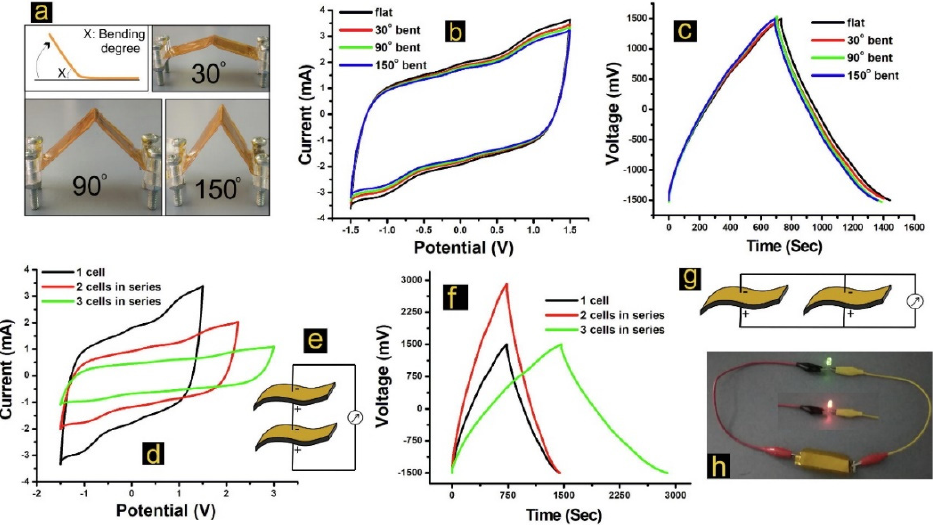
Figure 13. ( a ) Picture of flexible supercapacitor with different bending angles, ( b ) The CV of bent device with PAA-Co7 in different angles, ( c ) galvanostatic charge/discharge (GCD) profiles under different bending angles, ( d , e ) CV voltammograms of cells (1–3 cells) connected in series at a rate of 10 mV s − 1 , ( f , g ) comparison of GCD diagrams of cells with series and parallel connections, ( h ) picture of red-blue-green Light Emitting Diode (RBG LED) connected to charged supercapacitor. Reprinted with permission from Ref. [123]. Copyright 2021 Elsevier.